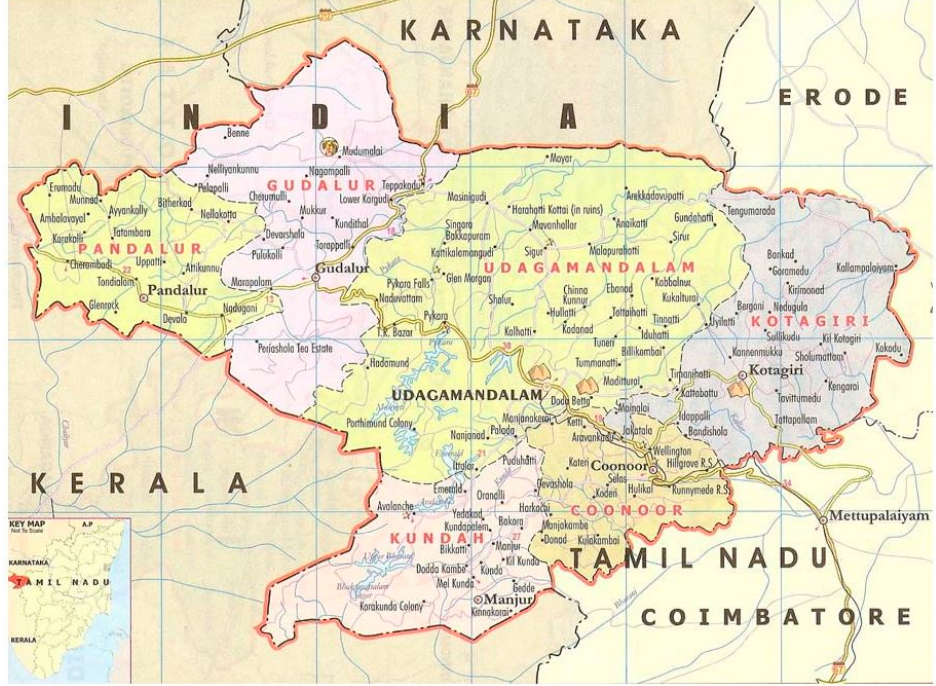
Figure 3. Source: Geographical position of the Nilgiris bounded by the states of Karnataka, Tamil Nadu, and Kerala (https://badaga.files.wordpress.com/2018/04/nilgiris.jpg, accessed on 13 Febru- ary